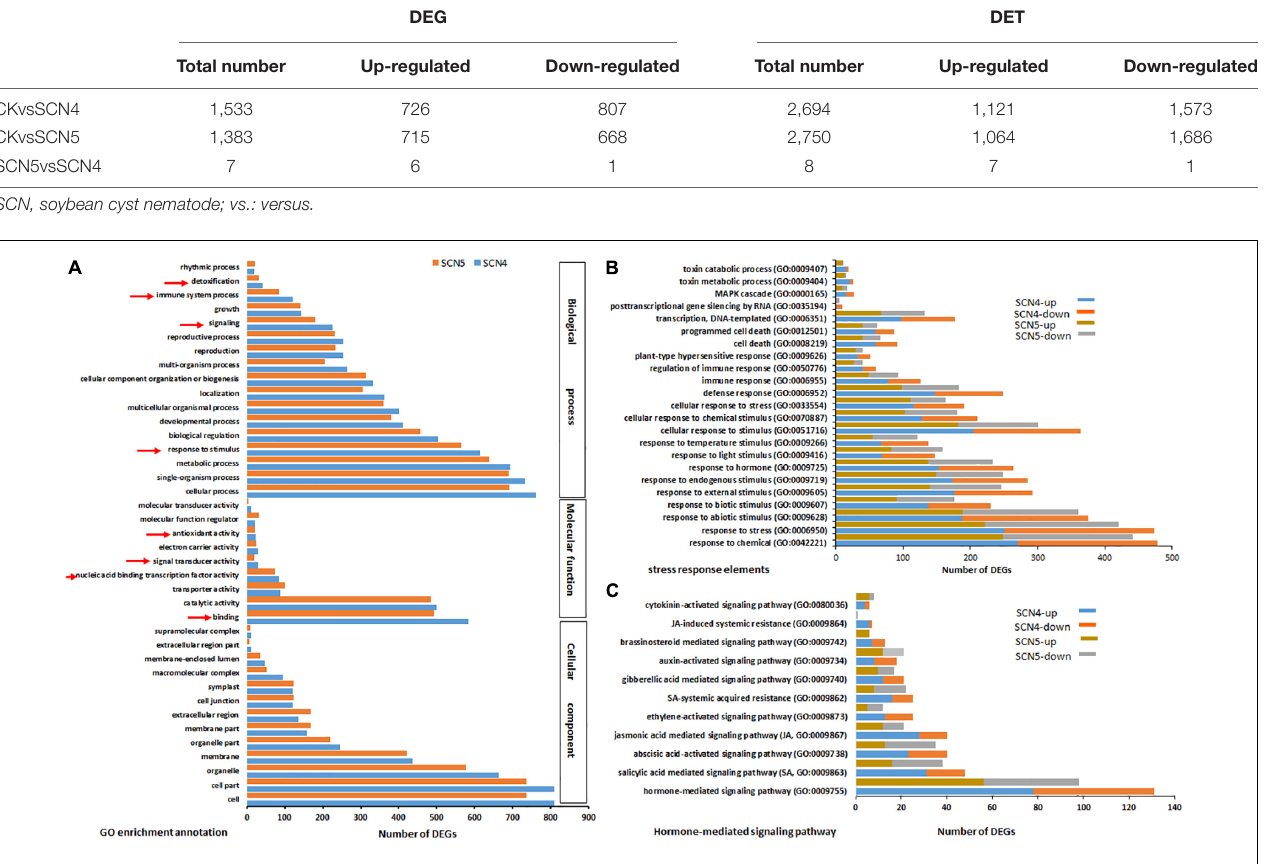
FIGURE 4 | Top GO-enriched annotation of the differentially expressed genes (DEGs) (A) and comparison of DEGs with up-/downregulation associated with stress response elements (B) and hormones (C) in soybean 09-138 infected by soybean cyst nematode race 4 (SCN4) and race 5 (SCN5) when compared with the control (CK). The red arrowheads in A indicate stress response